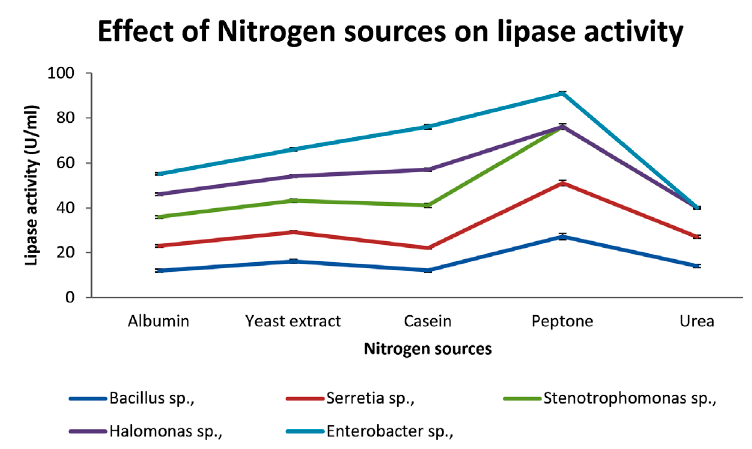
Fig. 5. Effect of various Nitrogen sources by lipase production